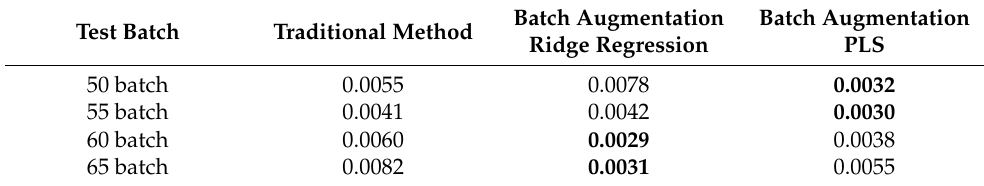
Table 4. RMSE comparison of 4 test batches quality